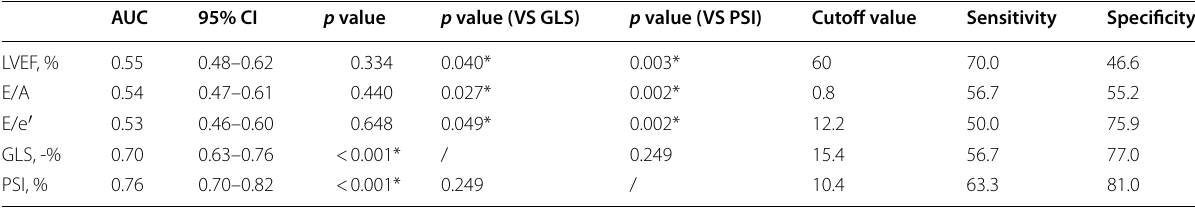
AUC: area under the curve; CI: confidence interval; LVEF: left ventricular ejection fraction; E/A: mitral inflow peak early velocity/mitral inflow peak late velocity; E/e ′ : mitral inflow peak early velocity/mitral annular peak early velocity; GLS: global longitudinal strain; PSI: post-systolic index * p < 0.05